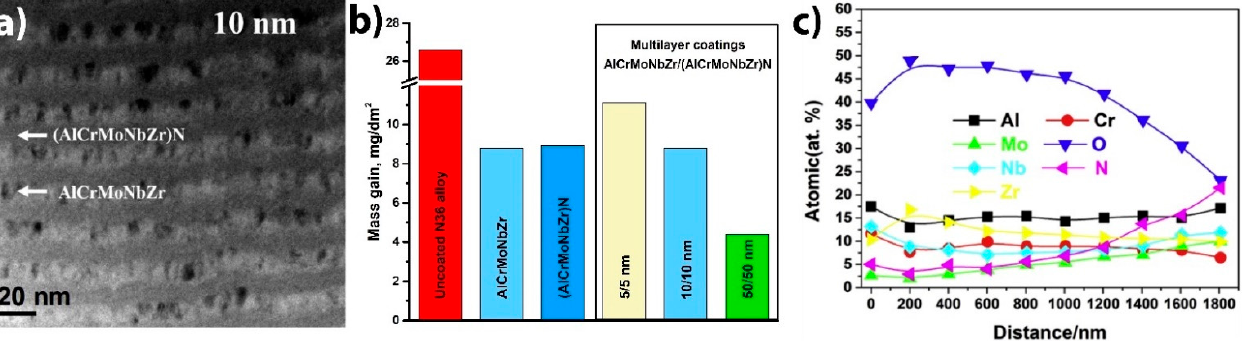
Figure 6. Multilayer AlCrMoNbZr/(AlCrMoNbZr)N HEA coatings: ( a ) cross section TEM image of 10/10 nm coating; ( b ) mass gains for HEA-coated N36 zirconium alloy after an autoclave test at 360 °C, 18.7 MPa for 30 days; ( c ) depth distribution of elements in 50/50 nm HEA coating after the autoclave test. Reproduced from [117] with permission by Elsevier.